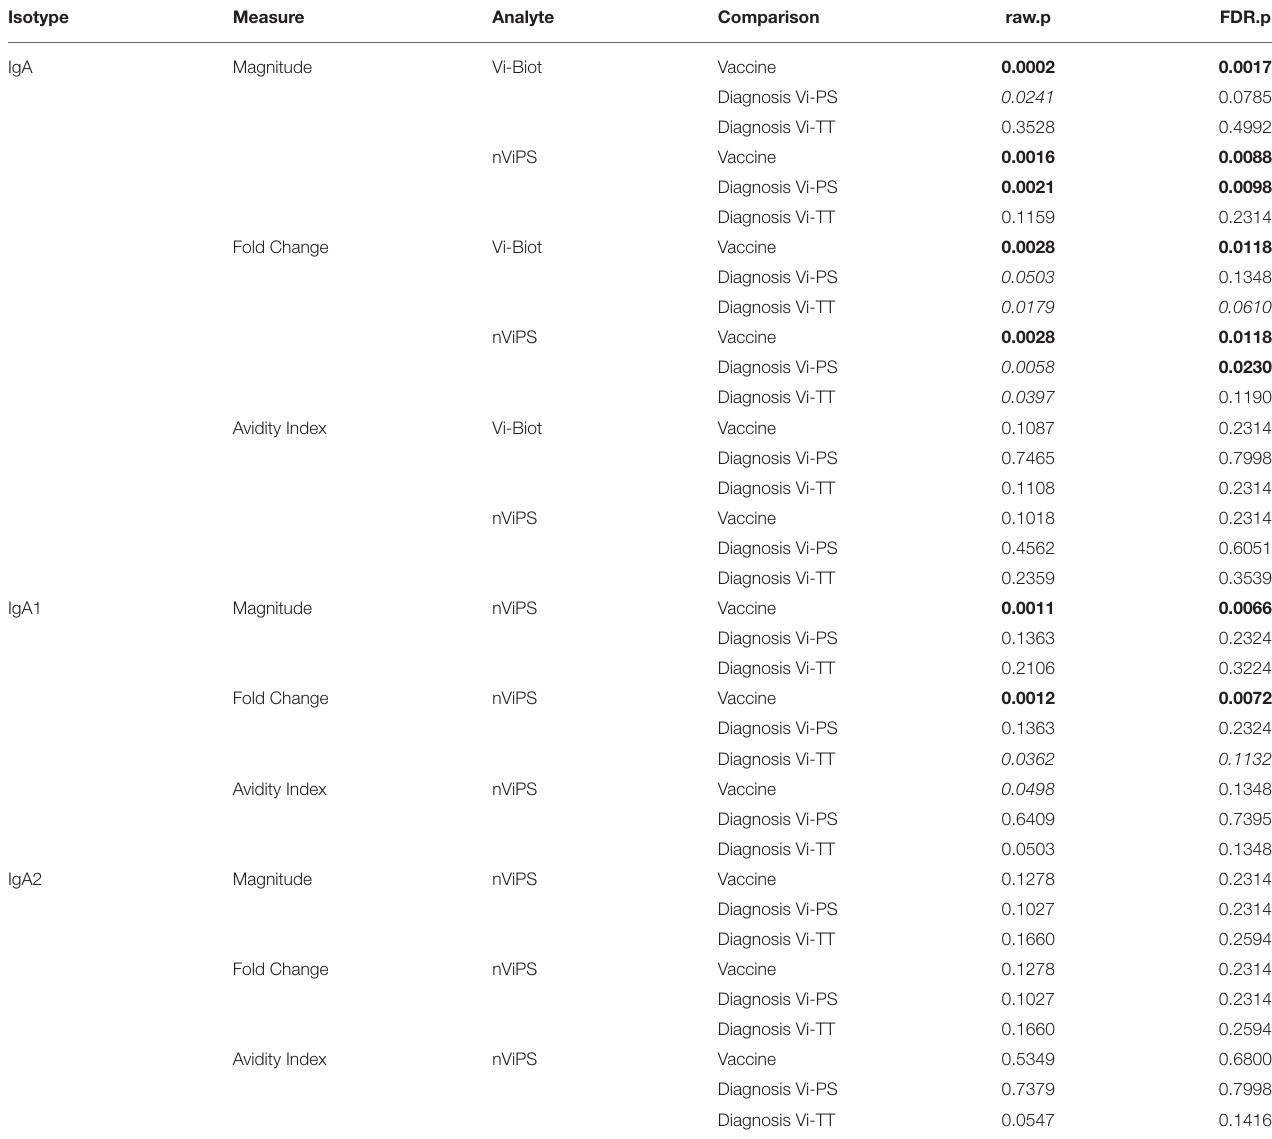
TABLE 3A | Primary statistical analysis of IgA responses to Vi at day of challenge (D0).